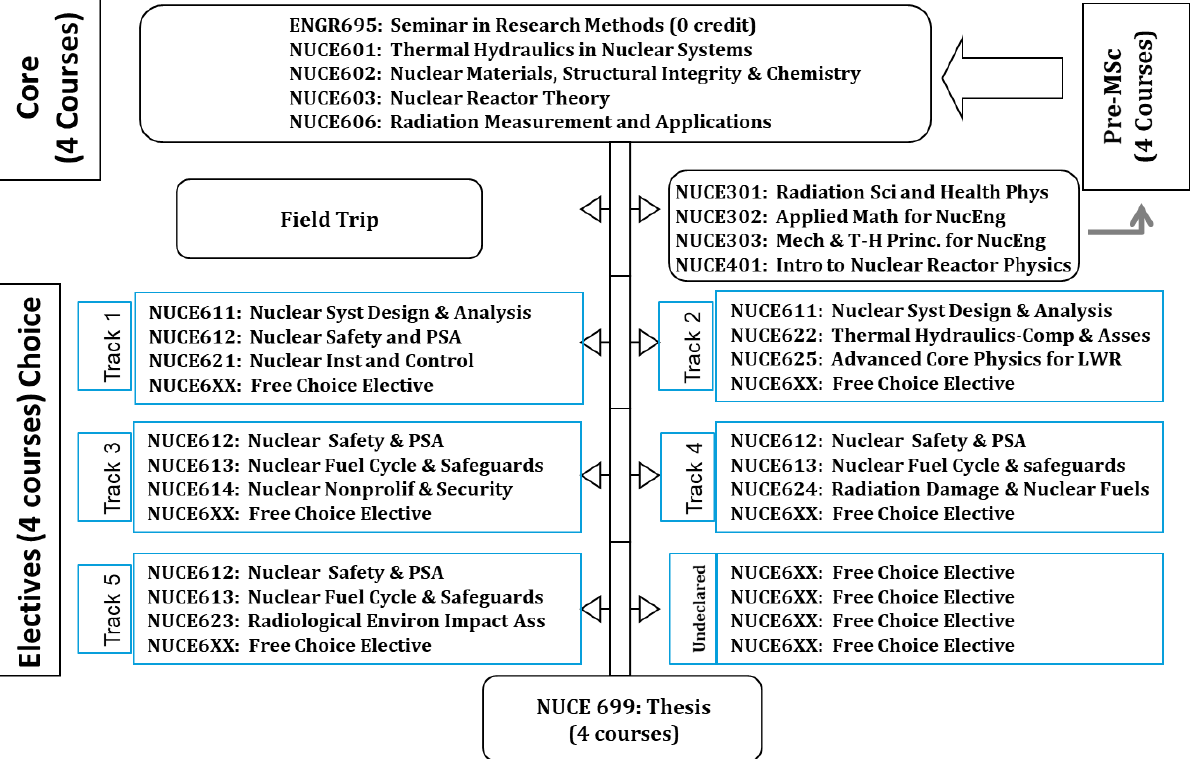
Figure 1 . Summary of MSc in NUCE Degree Program Structure and